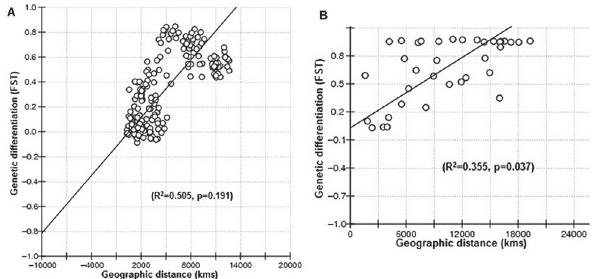
Fig 1. Genetic isolation-by-distance analysis by regression of genetic differentiation ( FST ) vs. geographic distance (km) (A) among Maruca vitrata population from different countries in Asia and Africa, and (B) among Maruca population from different continents or larger geographical